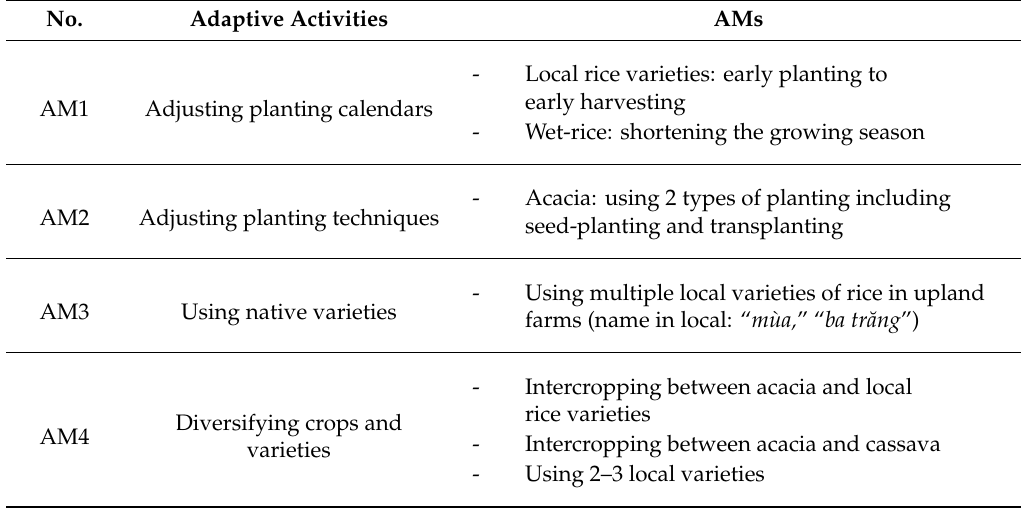
Table 7. Private adaptation measures (AMs) used in the farming